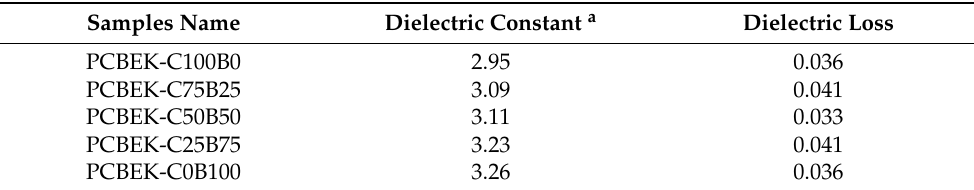
Table 6. Characterization of dielectric constant, dielectric loss, and water absorption of copolymer